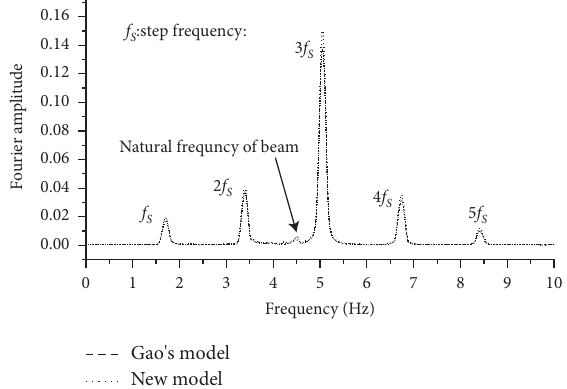
Figure 9: Spectrum of mid-span acceleration.